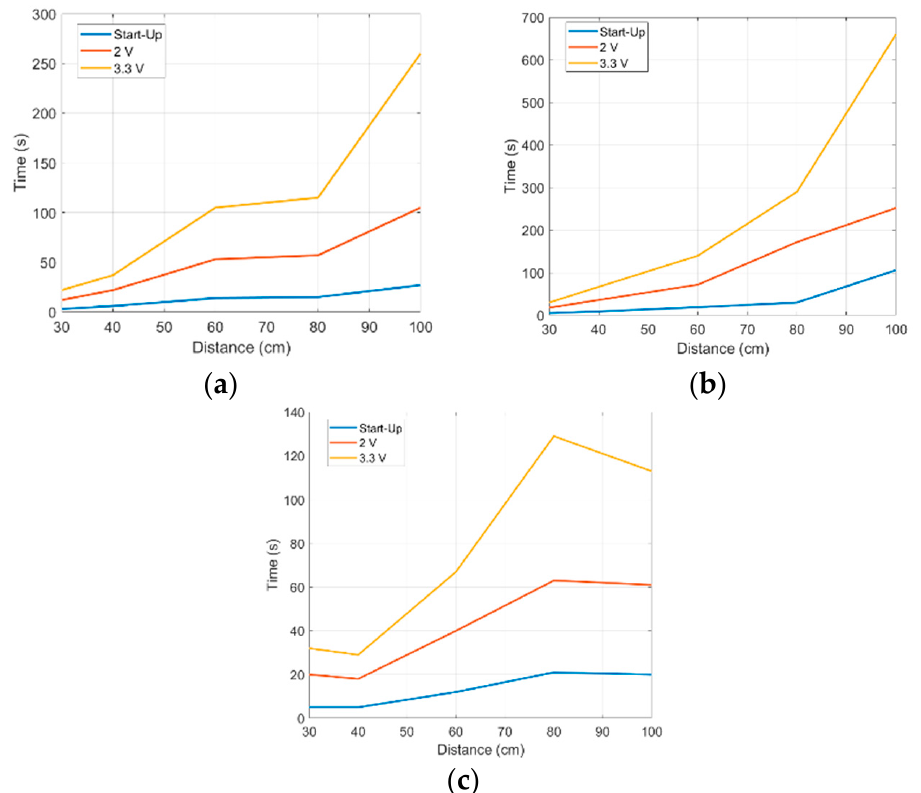
Figure 9. Representation of required times for the nodes to exit the cold-start and charge the storage capacitance at 2 and 3.3 V. Different distances and orientations with respect to the illuminator antennas have been considered: frontal node with ( a ) 0°, ( b ) 30°, and ( c ) 45° inclination with respect to the vertical axis.